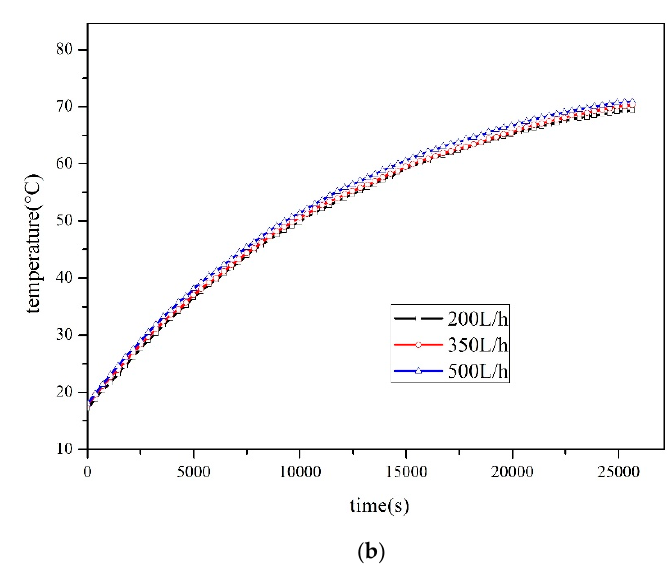
Figure 12. Collector outlet temperature curves under different flow rates. ( a ) SWH-PCM system; ( b ) SWH system.